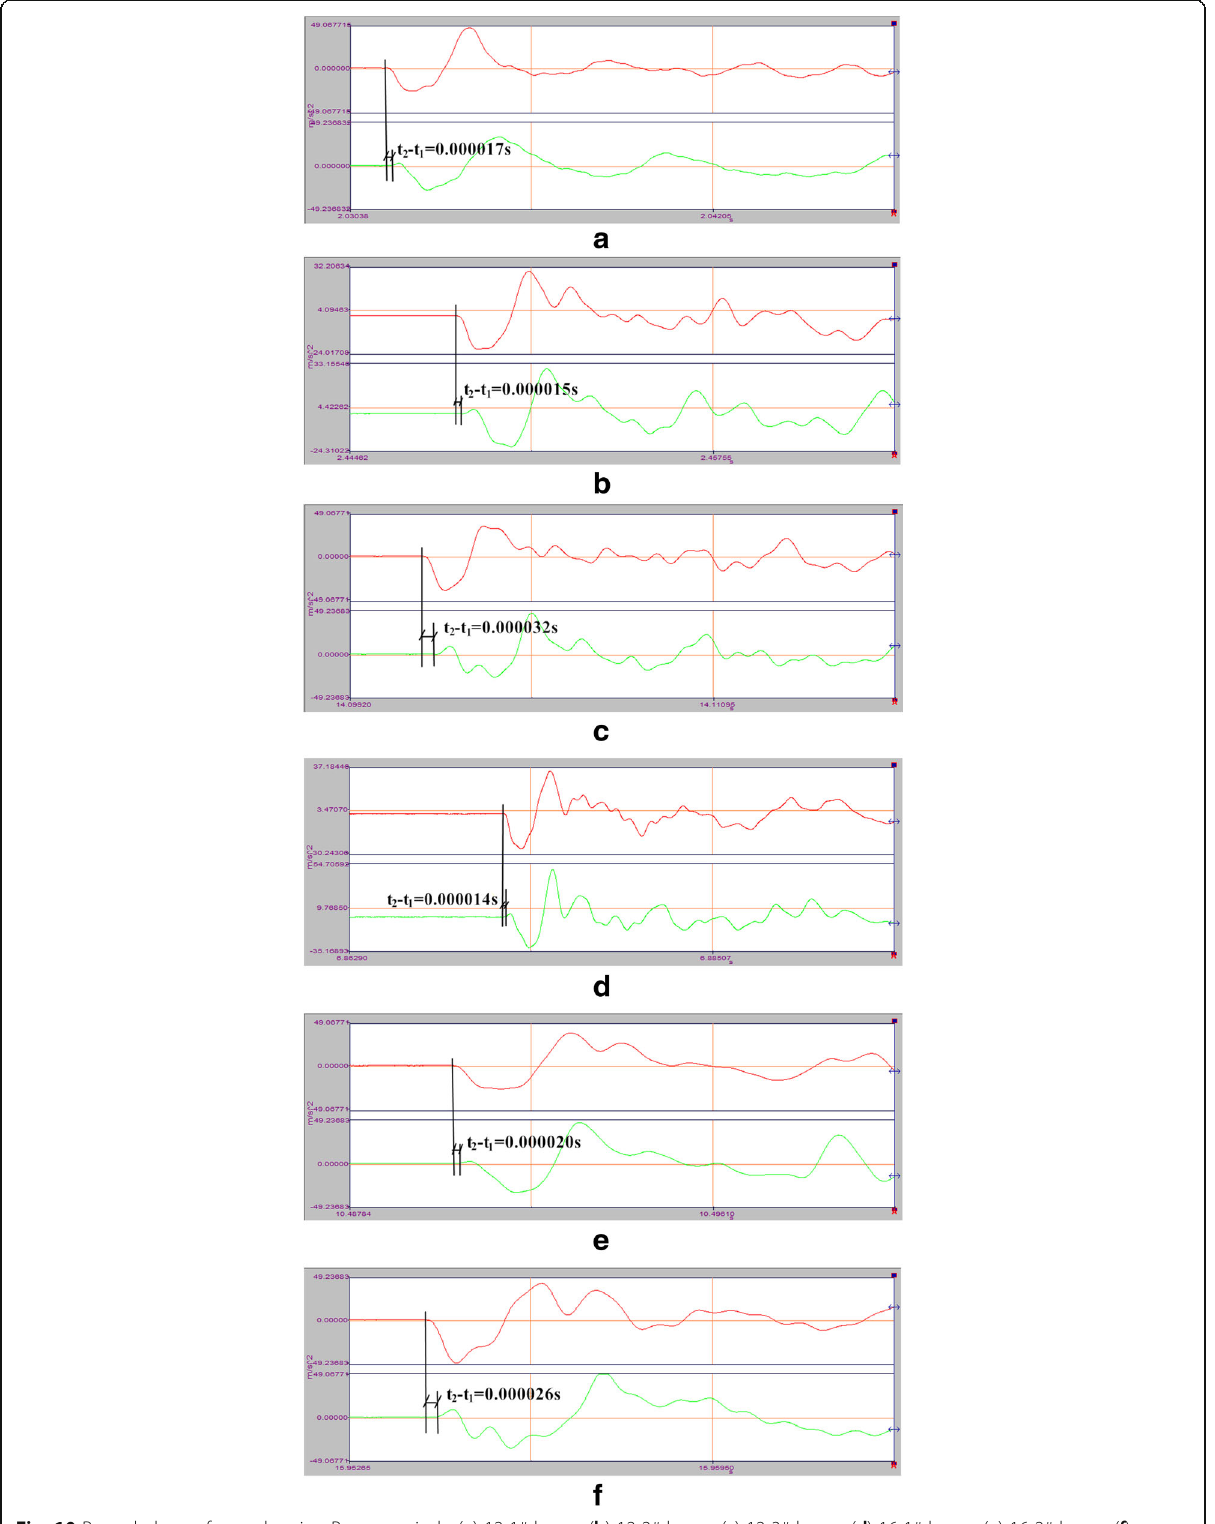
Fig. 10 Recorded waveforms showing P-wave arrivals: ( a ) 12-1# beam; ( b ) 12-2# beam; ( c ) 12-3# beam; ( d ) 16-1# beam; ( e ) 16-2# beam; ( f ) 16-3#